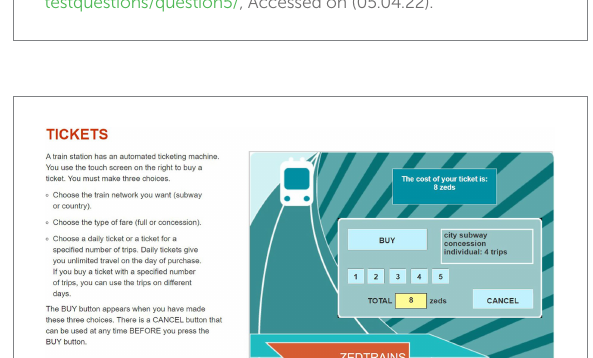
FIGURE 1 A snapshot of the first page of the problem- solving item (CP038q1) in Programme for International Student Assessment, 2012. Reproduced with permission from OECD, Tickets, PISA Test 2012 © OECD, 2012, https://www.oecd.org/pisa/test-2012/ testquestions/question5/, Accessed on (05.04.22).